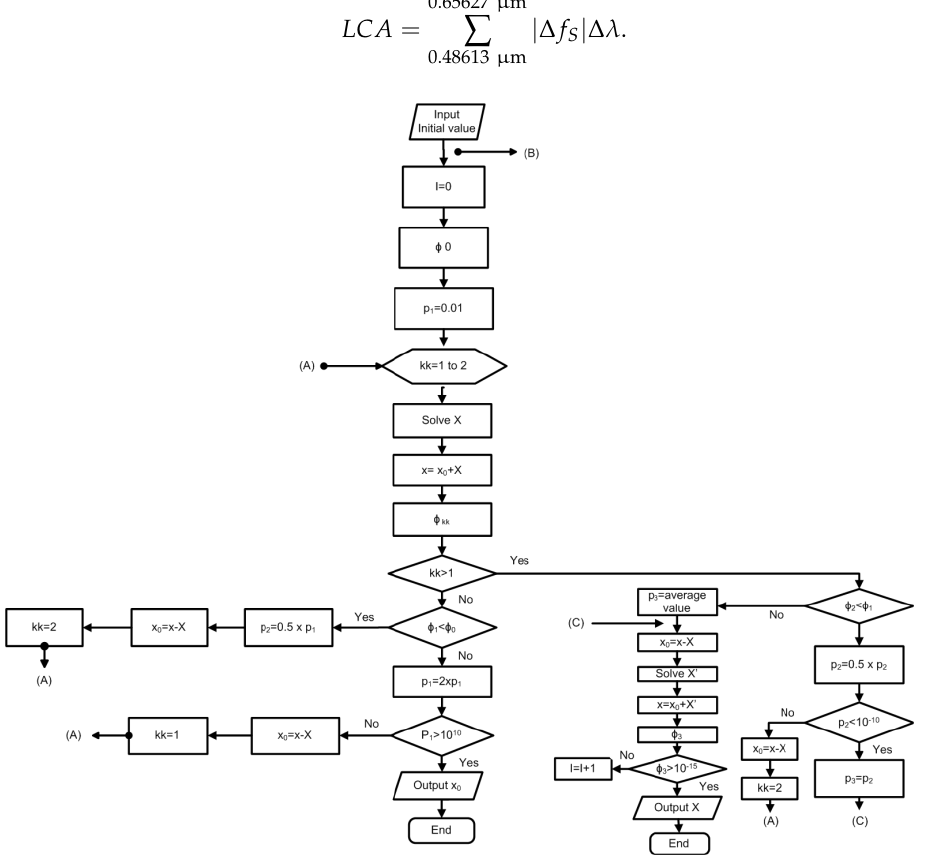
Figure 6. Flow chart of the optimization program. Table 2. Design parameters for the eight groups of thin triplet lenses selected by the illustration